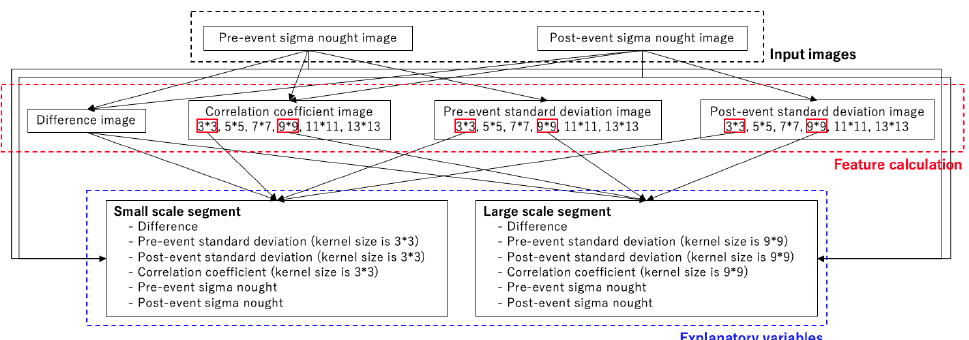
Figure 5. Structure of feature calculation. Red box indicates the kernel sizes that were selected to be used in the explanatory variables of machine learning